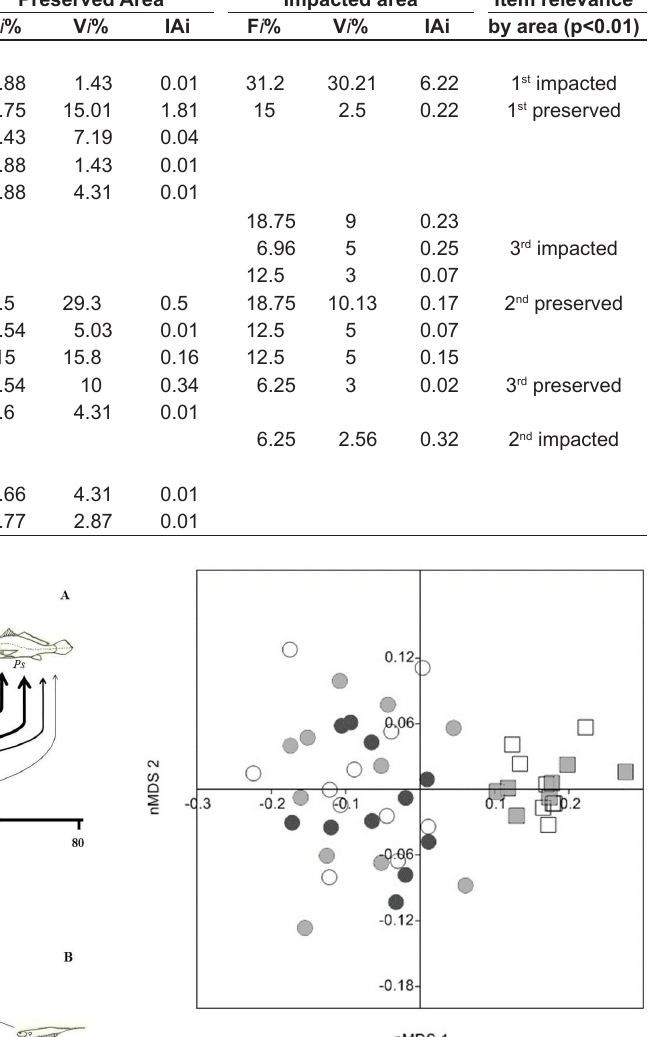
Figure 4. Non-metric multidimensional scaling analysis (nMDS) of volumetric data of the gut contents of P. squamosissimus in preserved area (circle) and impacted area (square), in Machado River (Brazilian Amazon), from June 2013 to March 2015. Carmita (dark gray circle), Farofa, (light gray circle), Suretama (white circle); São Sebastião (light gray square) and Poção (white